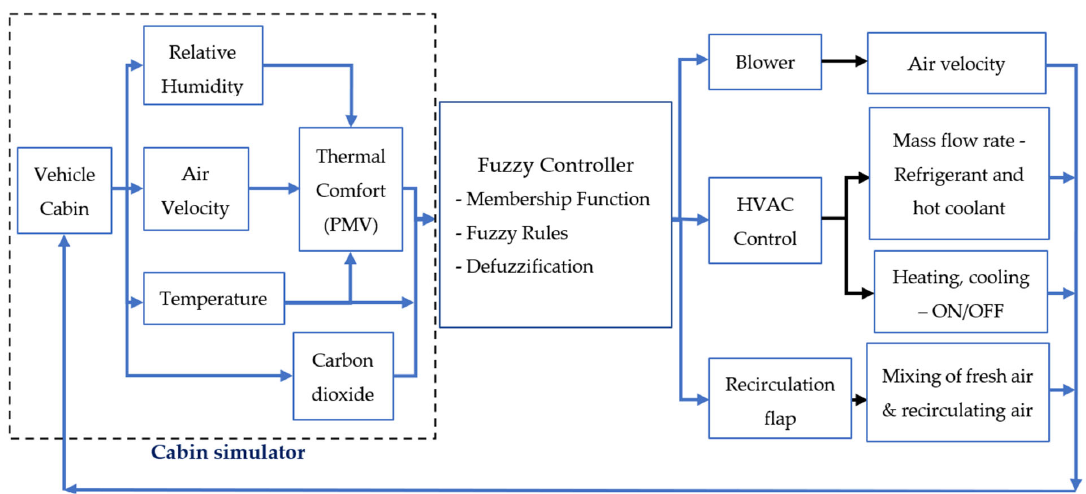
Figure 3. An overview of the simulator and controller subsystems in a vehicle HVAC